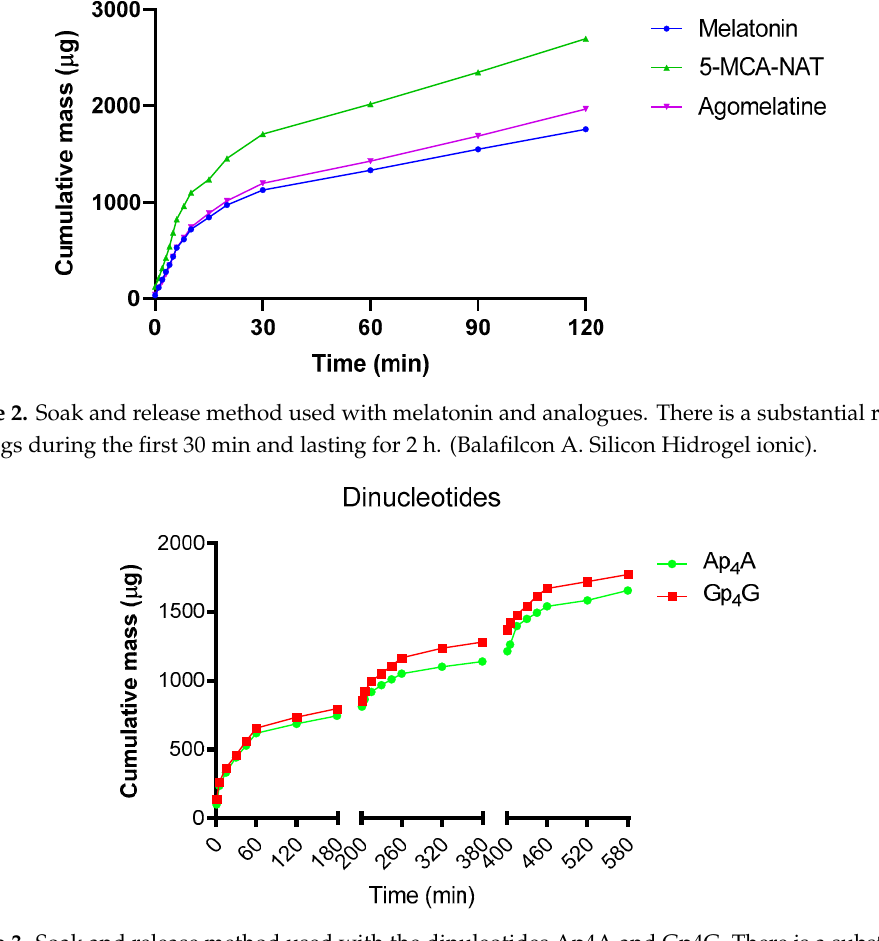
Figure 3. Soak and release method used with the dinuleotides Ap4A and Gp4G. There is a substantial release of drugs during the first 60 min, lasting 3 h that could be used for at least 3 consecutive